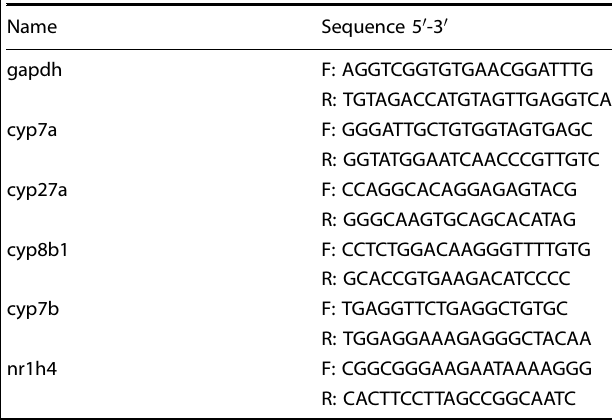
Table 1. Primer sequences for quantitative RT- qPCR ampli fi